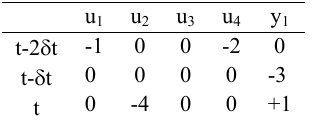
Table 1. Example of a FIR mask.